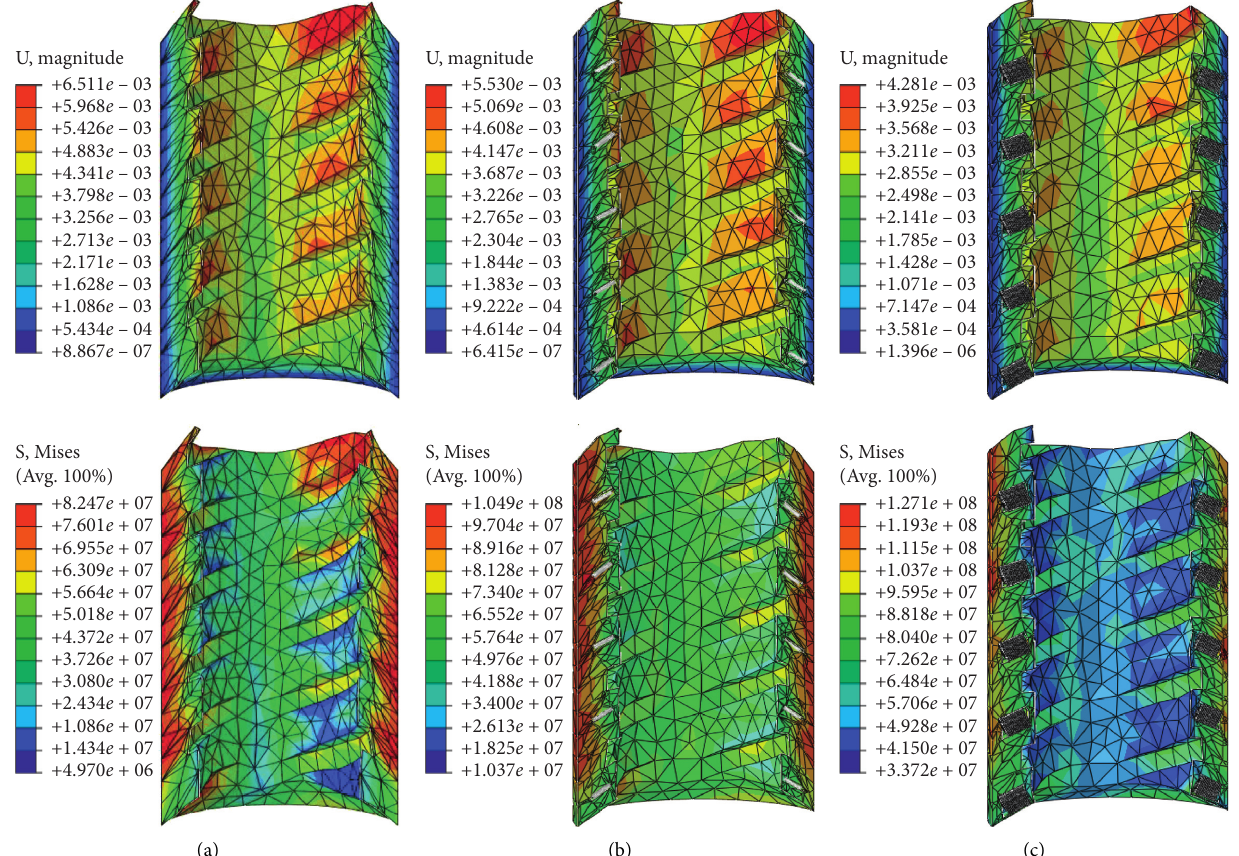
Figure 7: Displacement contour map of three types of resin grout under the same axial stress: (a) pure resin grout, (b) resin grout with 0.6mm diameter steel segment, and (c) resin grout with 3mm diameter steel